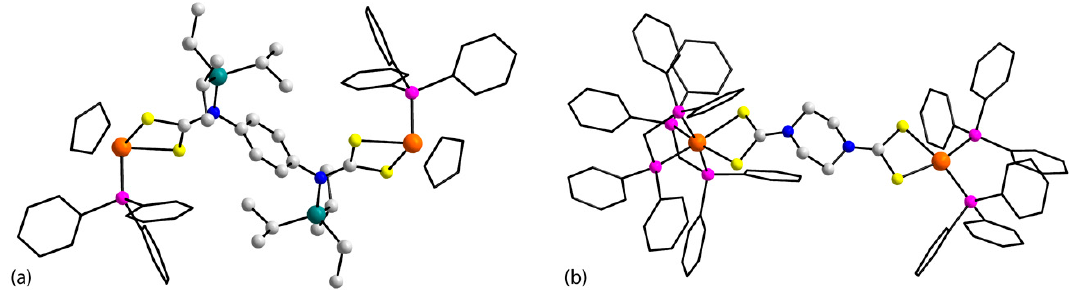
Figure 3. The di-nuclear molecules of ( a ) {[Cp(Ph 3 P)Ru] 2 (L 3 )} 2+ in 3 and ( b ) [(dppm) 2 Ru(L 2 )Pd(PPh 3 ) 2 ] 2+ in 4 . Additional colour code: teal, silicon; pink, phosphorus. The carbon atoms of the Cp, Ph 3 P, and dppm molecules are illustrated in stick